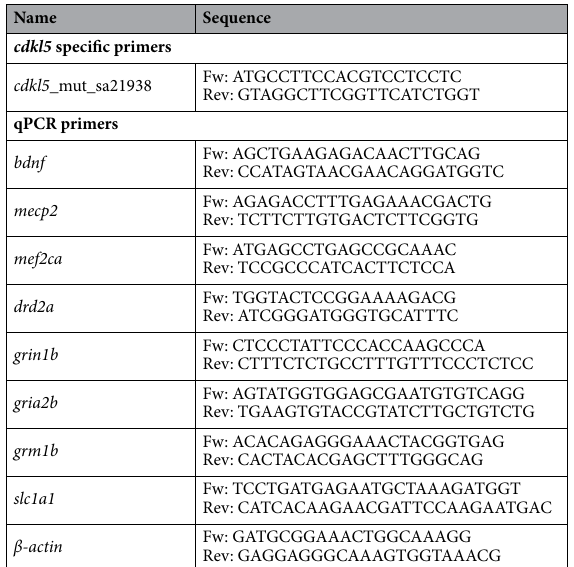
Table 1. List of primers used in this work. Fw Forward, Rev